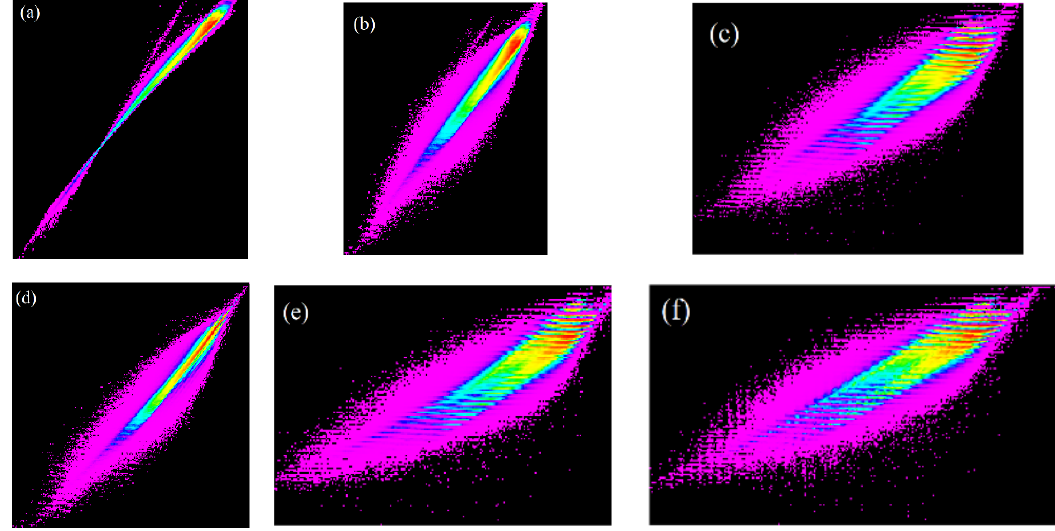
Figure 10. Scatterplot of evaporative fraction estimated for 5 August 2001 using different ET models for cropland showing ( a ) METRIC model ( ET r F ) versus SEBAL model ( EF ); ( b ) METRIC model ( ET r F ) versus SEBS model ( Λ ); ( c ) METRIC model ( ET r F ) versus SSEBop model ( ET f ); ( d ) SEBAL model ( EF ) versus SEBS model ( Λ ); ( e ) SEBAL model ( EF ) versus SSEBop model ( ET f ); and ( f ) SEBS model ( Λ ) versus SSEBop model ( ET f ). Axes values are such as diagonal line represents 1:1 line. Different colors in the scatterplots indicate density of points with red being the highest density and magenta being the least density.